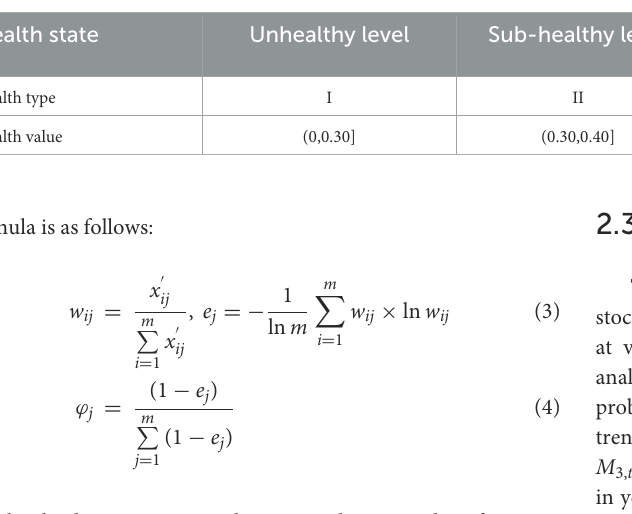
TABLE 1 Tourism ecosystem health level